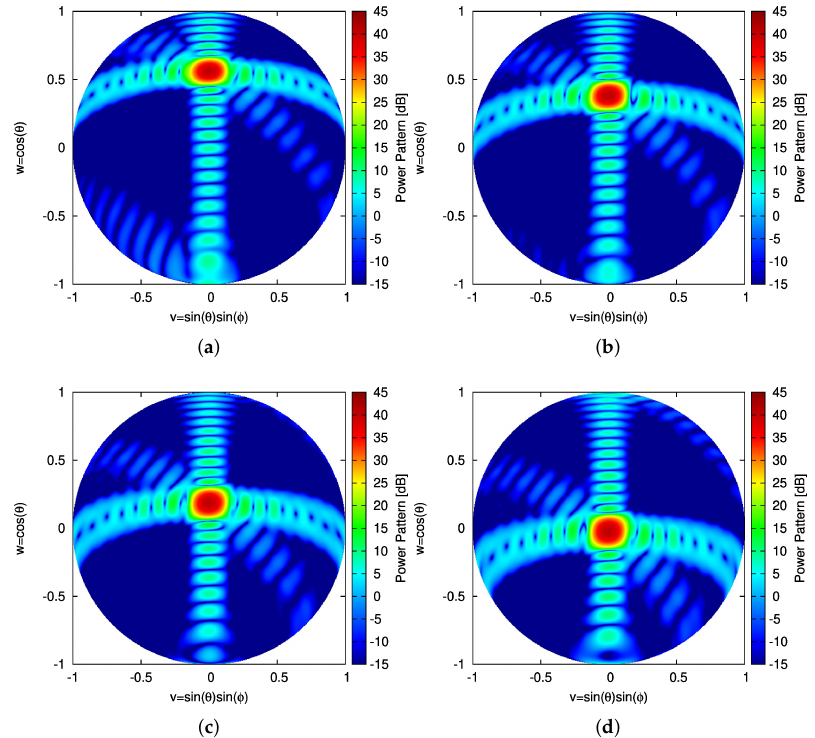
, B = 7, f 0 = 1.282 GHz, ψ = 30 ◦ )— 2